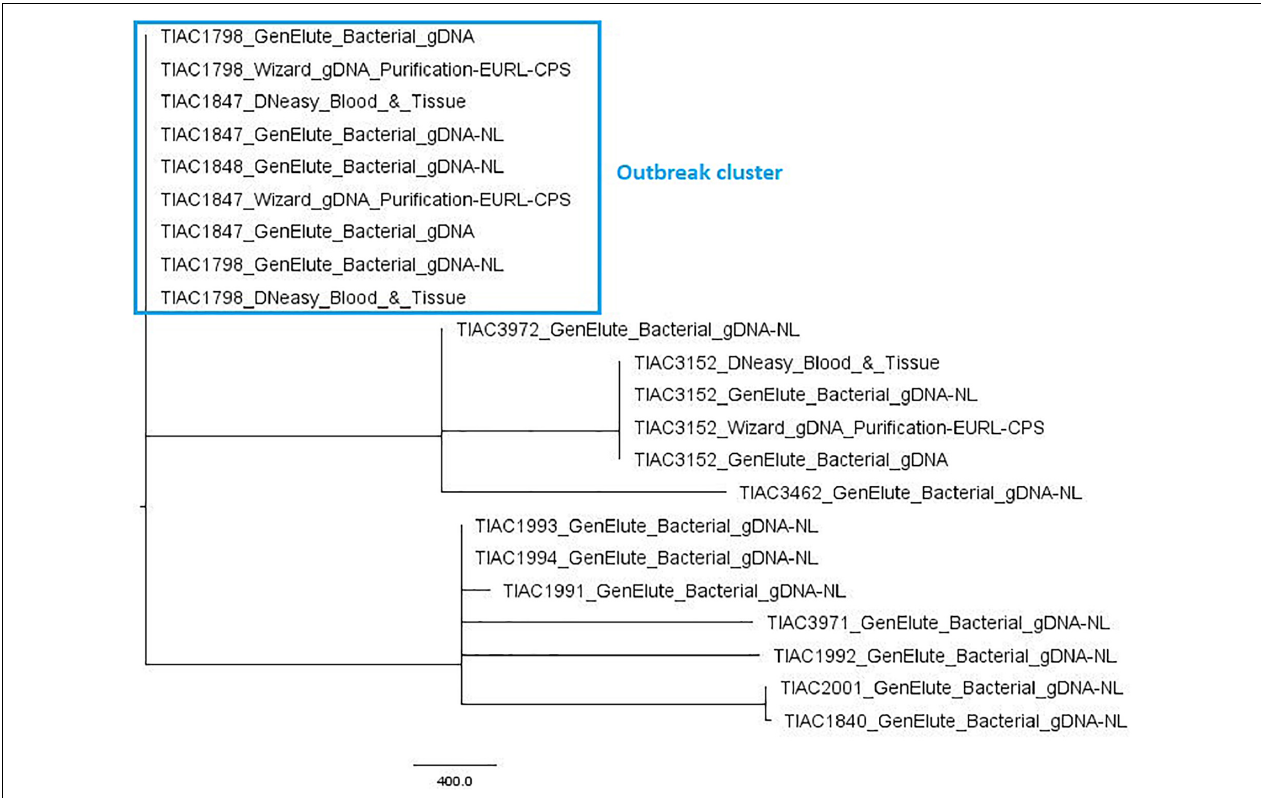
FIGURE 1 | Minimum spanning tree based on cgMLST for S. aureus isolates. A minimum spanning tree was created with GrapeTree using the MSTreeV2 method on all in-house sequenced outbreak and non-outbreak samples, i.e., all isolates, some of which processed with different DNA extraction kits. The sample names in the figure consist of the name of the respective isolate and an abbreviation of the applied DNA extraction kit, i.e., GenElute_Bacterial_gDNA-NL: GenElute Bacterial gDNA kit using the protocol for Gram-positive bacteria [without (i.e., no) lysostaphin, NL]; GenElute_Bacterial_gDNA: GenElute Bacterial gDNA kit using the protocol for Staphylococcal species (with lysostaphin); DNeasy_Blood_&_Tissue: DNeasy Blood & Tissue kit; Wizard_gDNA_Purification: Wizard gDNA Purification kit. The outbreak samples (outlined in the blue box) from food origin (TIAC1798) consistently cluster together with those of human cases (TIAC1847 and TIAC1848) while non-outbreak samples (TIAC1840, TIAC1991, TIAC1992, TIAC1993, TIAC1994, TIAC2001, TIAC3152, TIAC3462, TIAC3971, and TIAC3972) are separated from the outbreak cluster and delineated per isolate (except for TIAC1993 and TIAC1994 sampled from the same person that also cluster together because of their identical cgMLST profiles). The scale bar represents the number of cgMLST allele differences between samples. No cgMLST allele differences were identified between the outbreak isolates, nor isolates processed with different DNA extraction